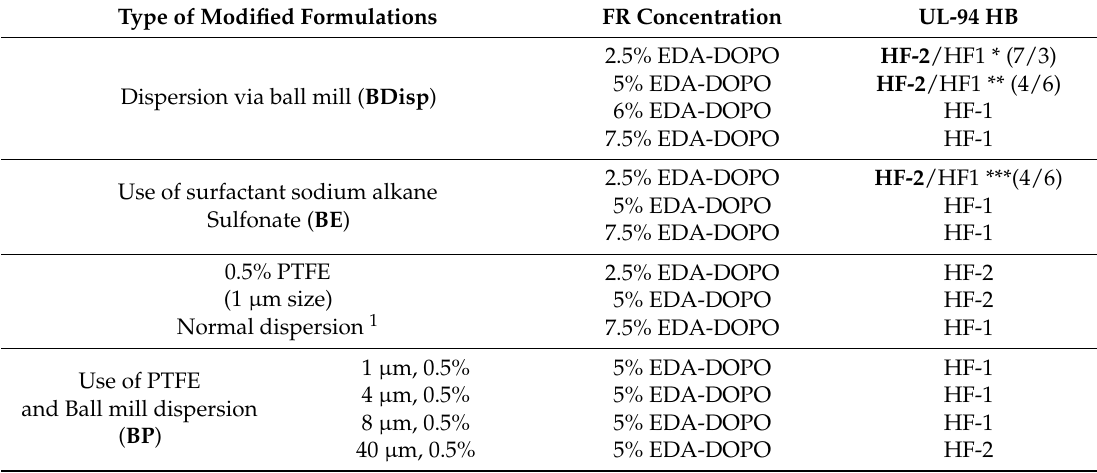
Table 5. UL 94 HB results for PU foams from Modified B